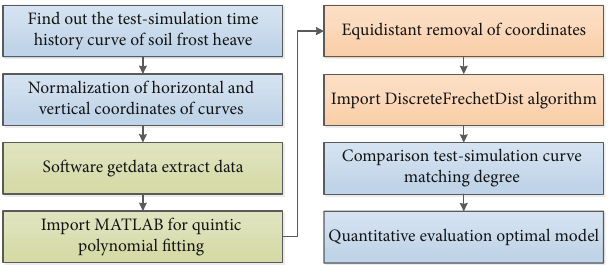
Figure 3: The fl ow chart for calculating the matching degree of the mathematical physics